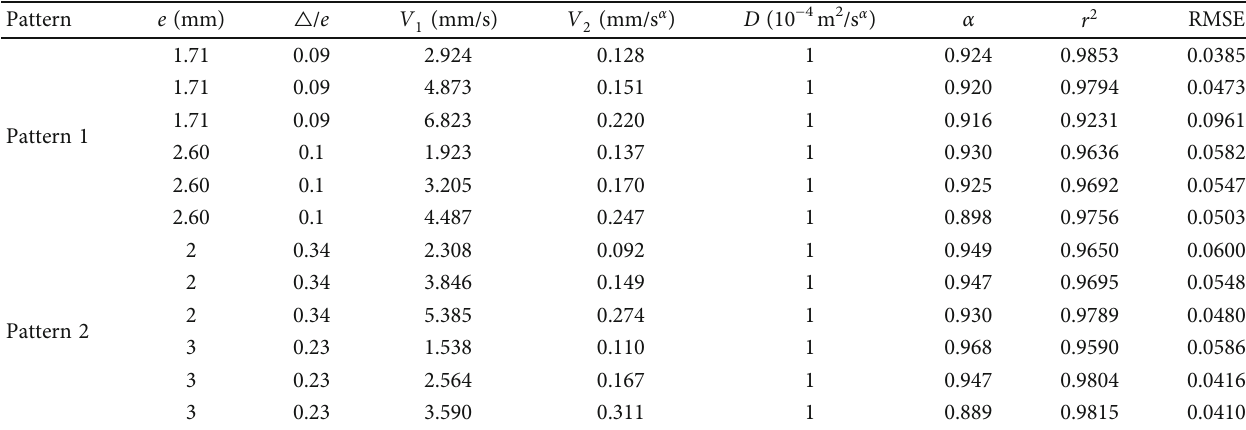
Figure 7: Scatter diagram of r 2 and RMSE for the tFADE and ADE in the group 2. Table 5: Fitting parameters by the tFADE in the experiments of group